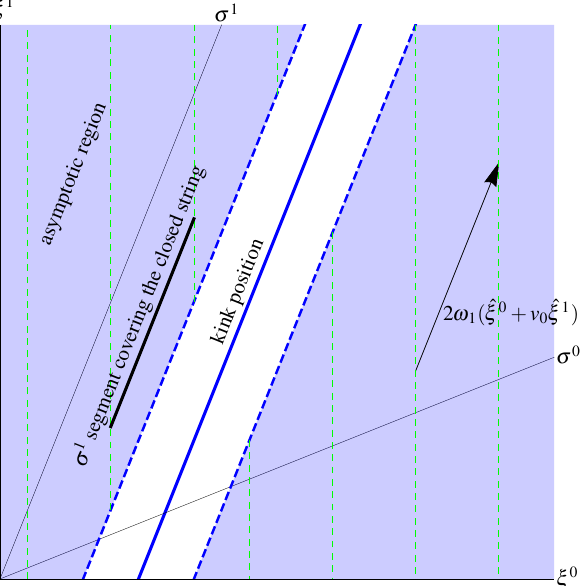
Fig. 19 Taking advantage of the periodicity properties of the sine- Gordon counterpart to form a special exact finite closed string ϕ dress 0 /